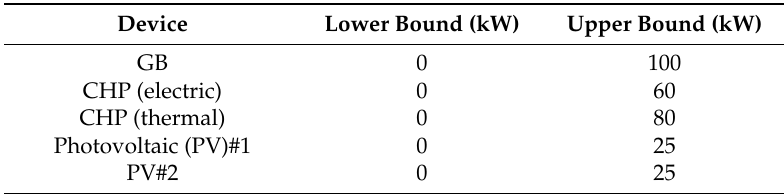
Table 6. Capacities of devices.